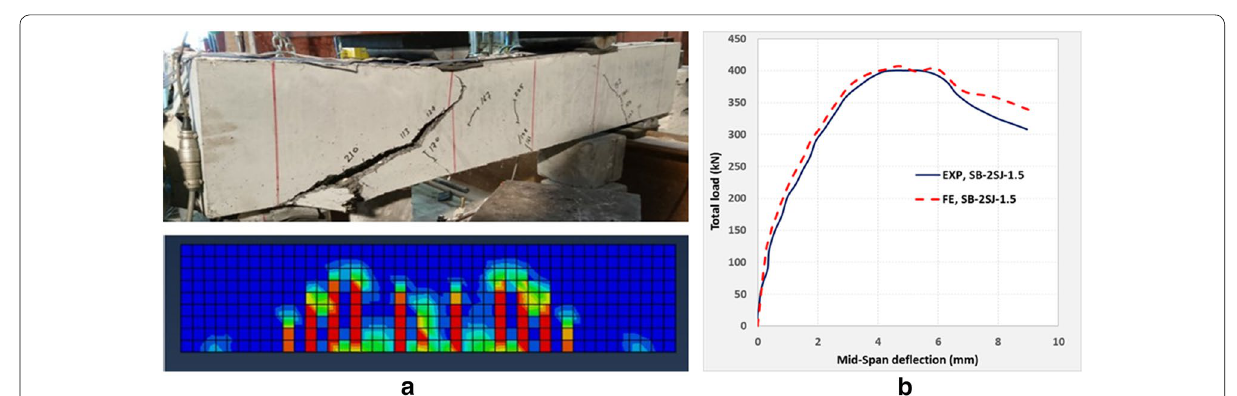
Fig. 21 Retrofitted beam (SB‑2SJ‑1.5): a failure mode, b load–deflection